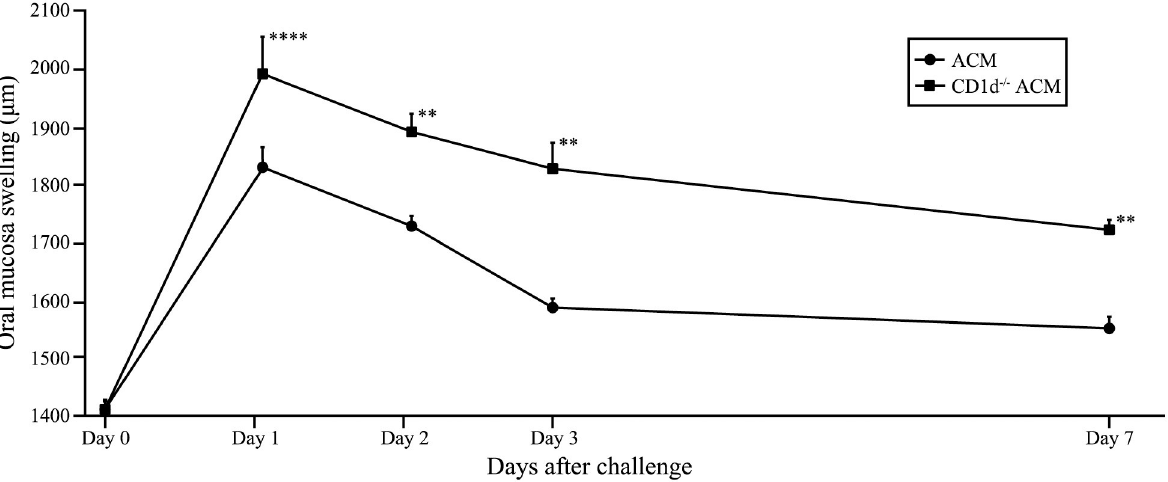
Fig 10. Swelling of the oral mucosa in CD1d -/- Ni-induced allergic mice. Buccal area swelling from days 1 to 7 after challenge was significantly higher in CD1d -/- ACM mice compared with ACM mice. Bars and error bars indicate mean plus standard deviation. Statistical significance was tested by the Mann–Whitney U- test ( �� p < 0.01, ���� p <